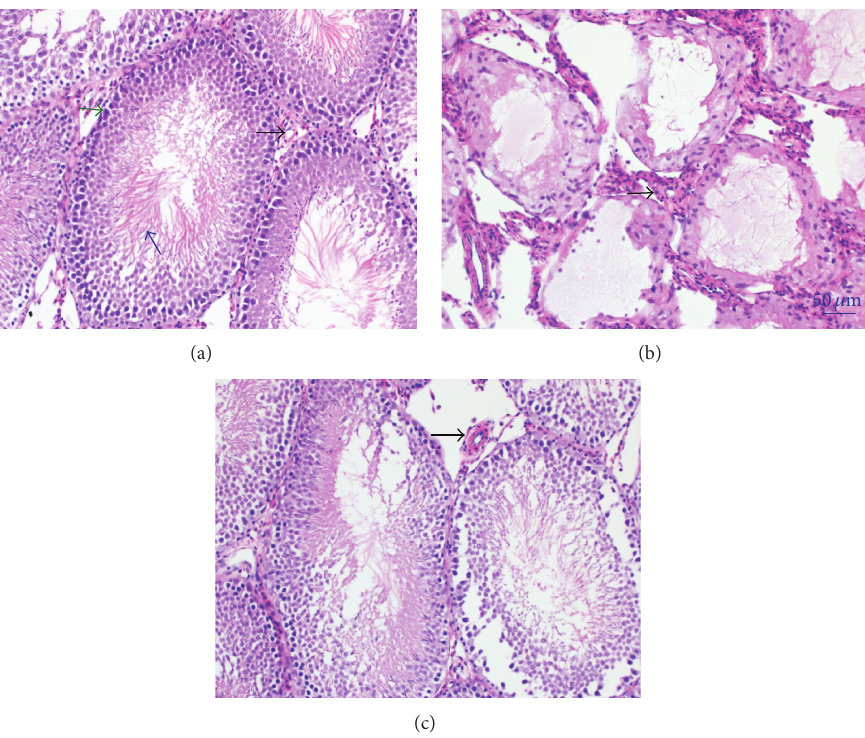
Figure 4: H&E staining of testicular tissue changes. (a) H&E staining in control rats (200x), germ cells (green arrow), spermatozoa (blue arrow), and blood vessel (black arrow) was indicated. (b) H&E staining in diabetic rat (200x). (c) H&E staining in diabetes + SCU rat (200x).